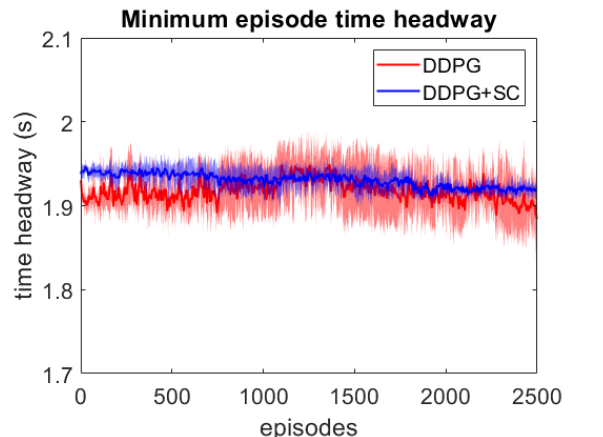
Figure 7. Comparison of the deep vehicle following agents’ minimum TH per episode over adversar- ial training runs with lead vehicle velocity limits v lead ∈ [ 12,30 ] m/s. Averaged over 3 runs, with standard deviation shown in shaded